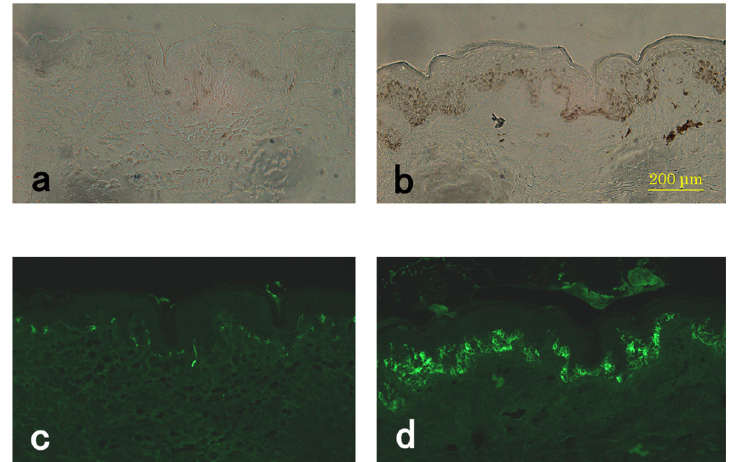
Figure 4. Expression of PMEL17 in the SL lesion and perilesional normal skin. Representative sections of perilesional ( a , c ) and SL lesional ( b , d ) skin from the same subject (#5). Light microscope images ( a , b ) and immunostaining of PMEL17 ( c , d ).